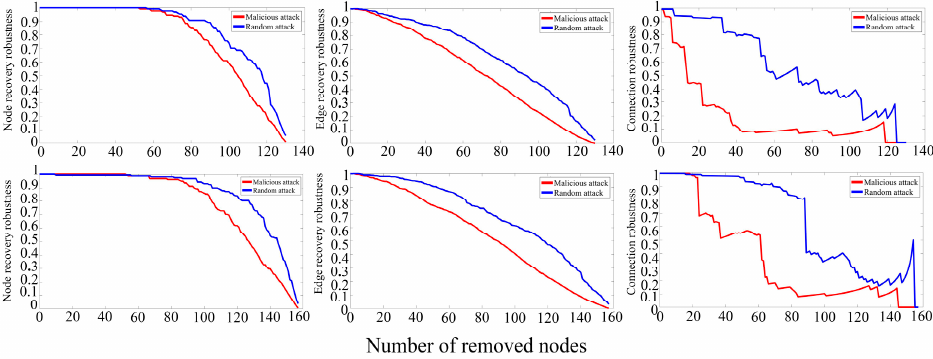
Figure 11. Robustness of ecological space network before and after optimization.